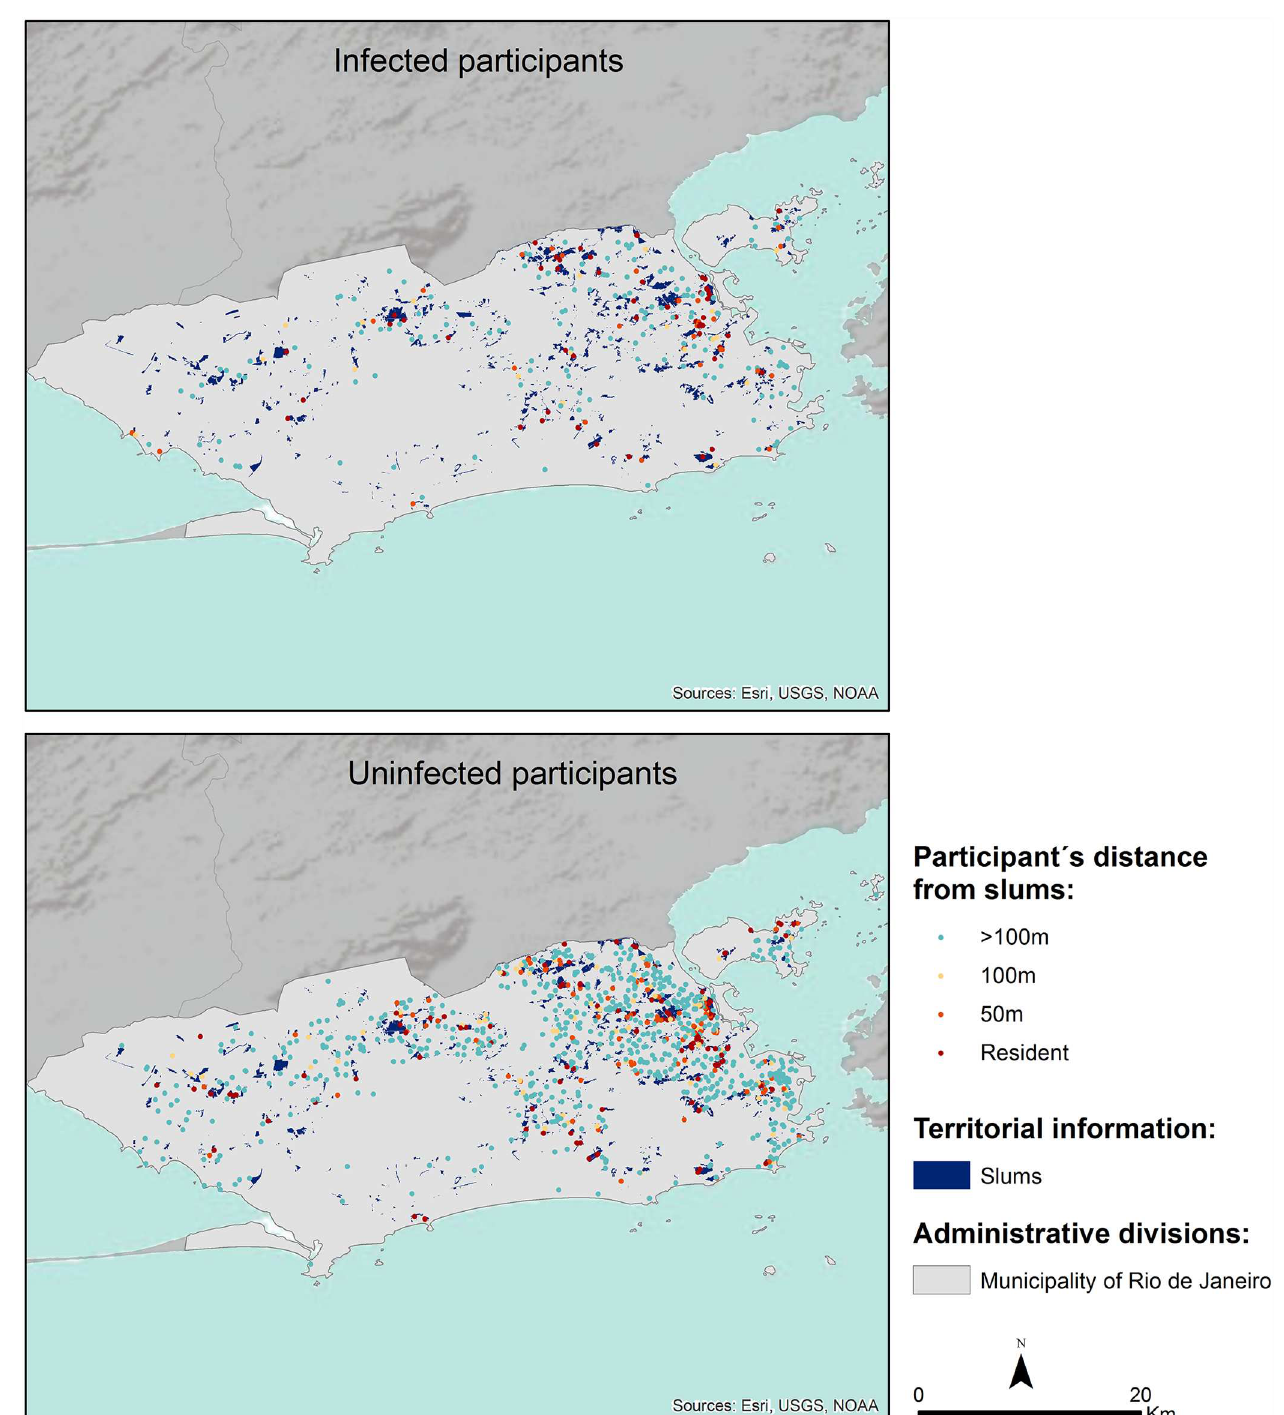
Fig 4. Geographical distribution of participants with and without intestinal parasitic infections and their distance over the slums in Rio de Janeiro municipality.